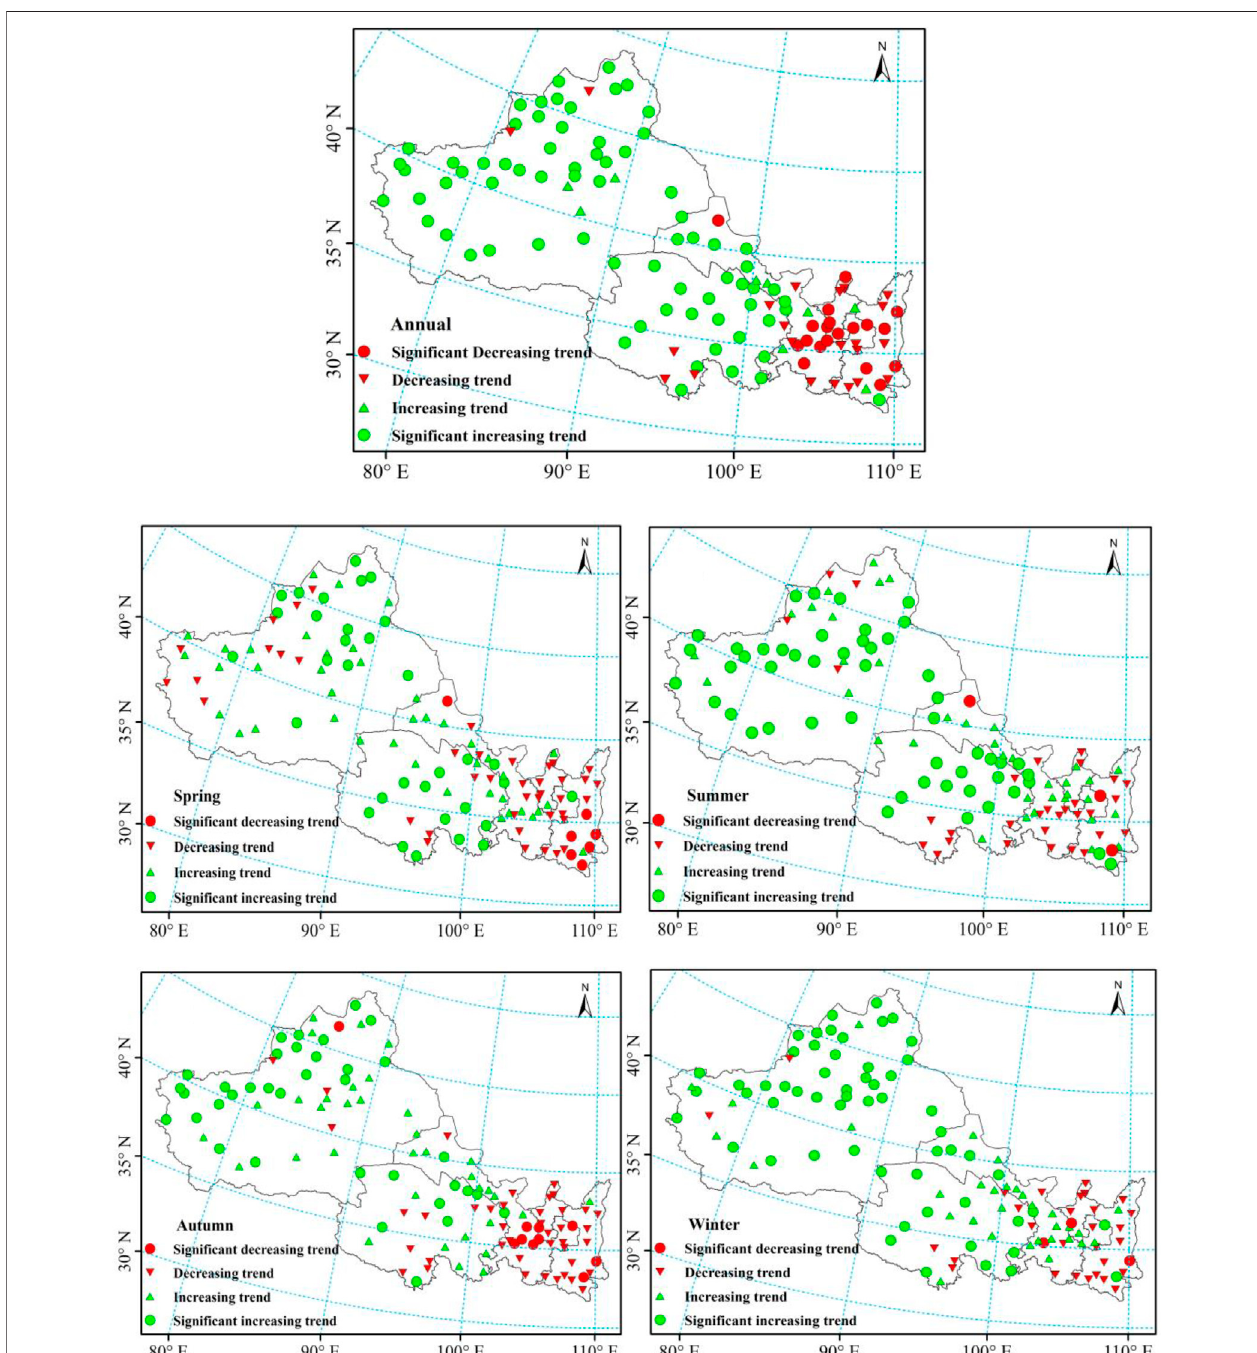
FIGURE 6 | Spatial distribution of annual and seasonal Z-statistics of SPI by TFPW-MK.